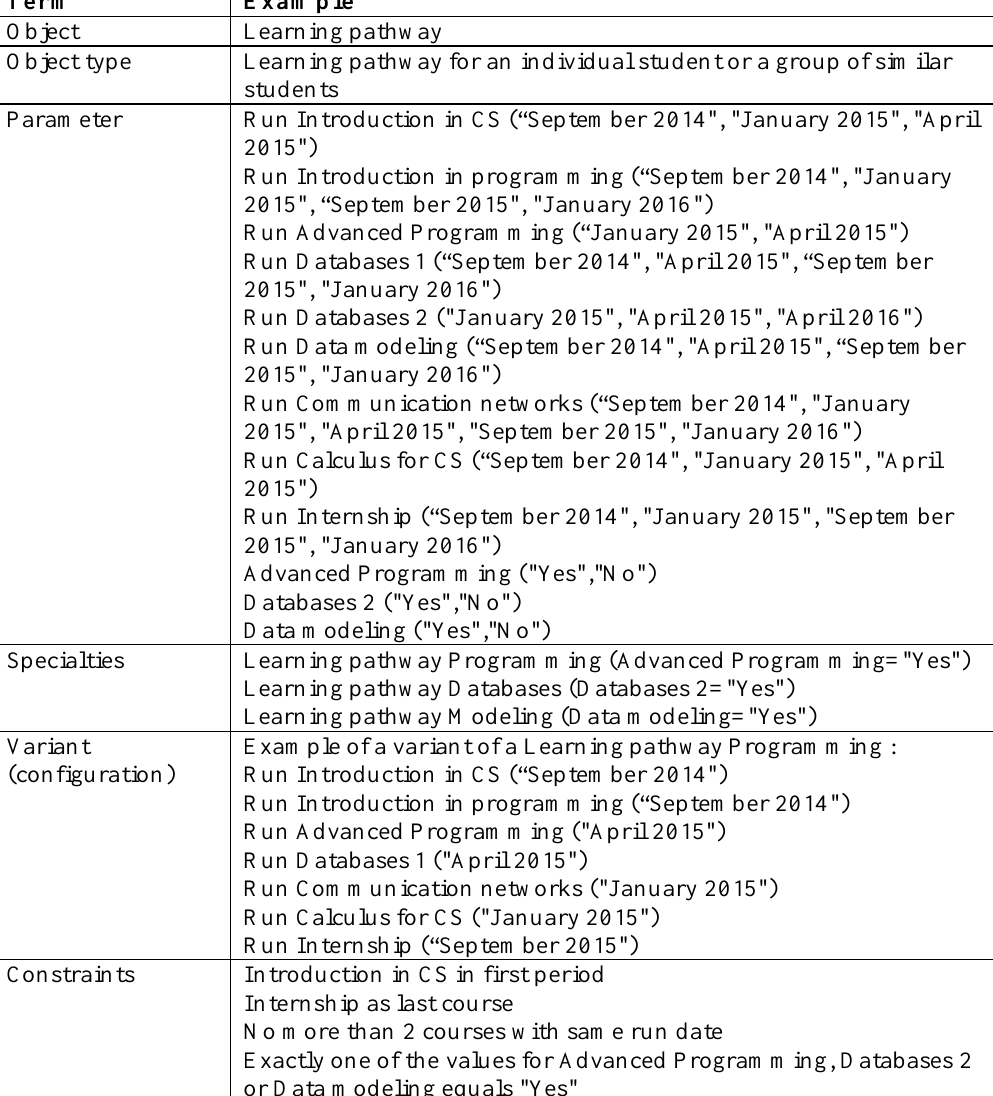
Example of Parameterization of a Learning